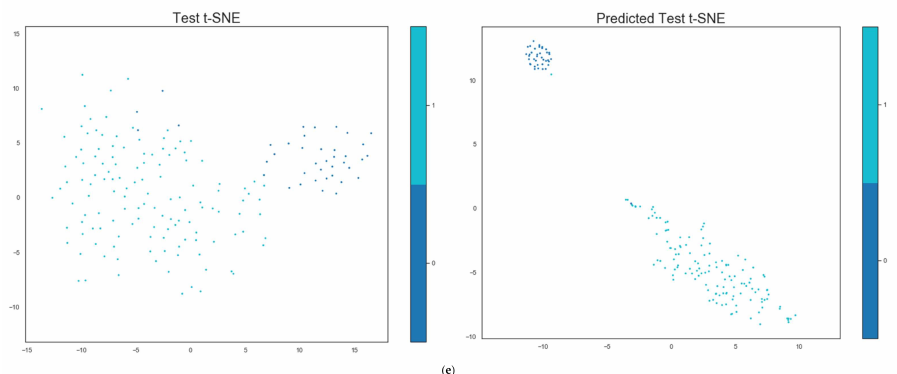
Figure 6. TSNE visualizations of the test set without mapping (left) vs. mapped with our model (right): ( a ) MNIST; ( b ) Fashion-MNIST; ( c ) USPS; ( d ) MSTAR; ( e )